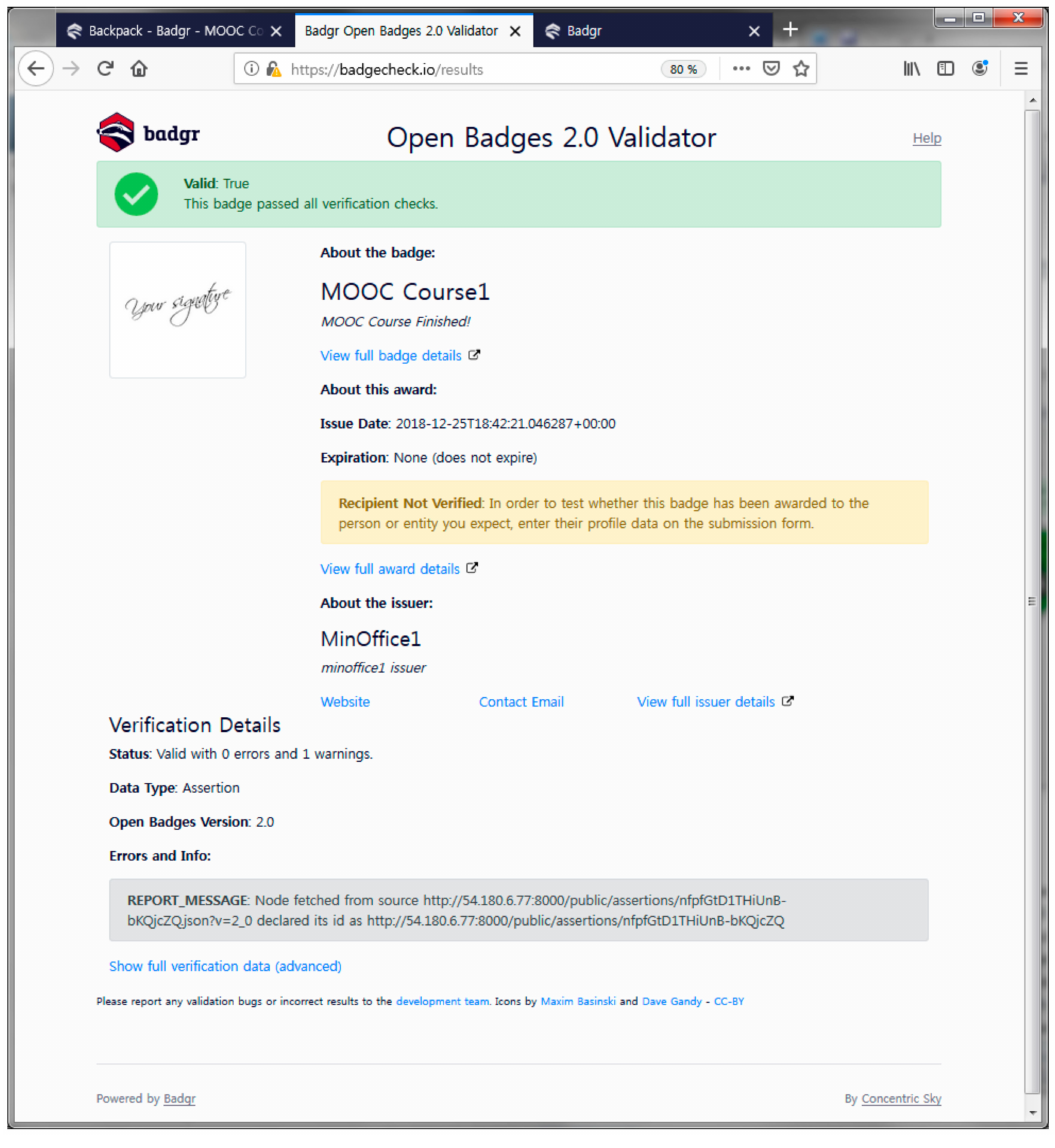
Figure 23. Badge award & validation (step